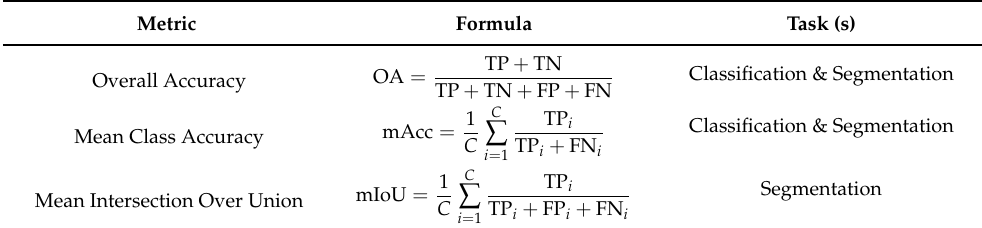
Table 2. Evaluation metrics. C denotes the number of classes. TP, TN, FP, and FN are the true positive, true negative, false positive, and false negative,